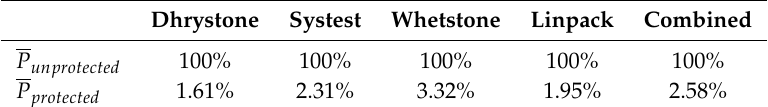
Table 6. Normalized percentage of undetected errors for both unprotected and DTMR-protected versions of the Rocket RISC-V